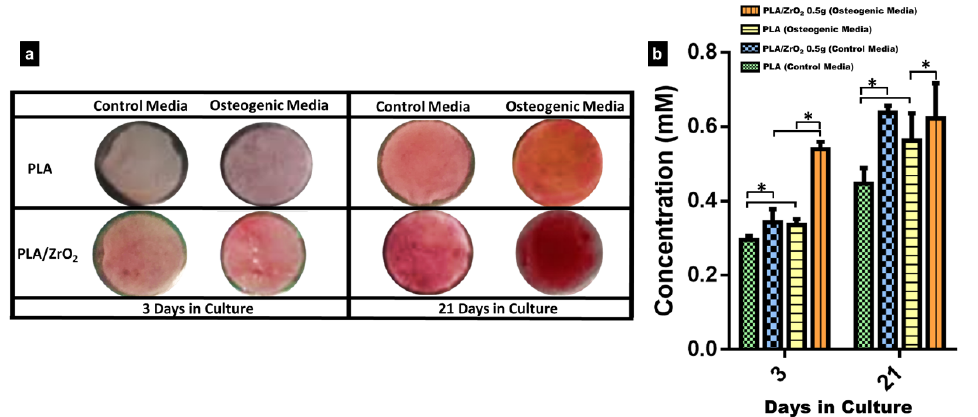
Figure 6. Alizarin red staining. The hFOB cells were cultured onto the PLA and PLA/ZrO 2 with the presence or absence of an osteogenic medium. ( a ) The calcified extracellular matrix deposits produced by hFOB cells onto the PLA/0.5 g ZrO 2 composite scaffolds are red. The area of the calcified deposits onto the scaffolds was time-dependent and increased with the culture time. However, the calcium deposit onto the PLA/0.5 g ZrO 2 scaffolds in the osteogenic medium, compared with the standard medium, was more visible, and the concentration of the alizarin was higher than in the PLA scaffolds. ( b ) The calcium (mM) concentration in PLA/0.5 g ZrO 2 scaffolds after 3 and 21 days of culture in osteogenic medium and standard medium. Asterisk (*) mean that the scaffolds showed a statistical significance ( p < 0.05). Moreover, the PLA scaffold and PLA/ZrO 2 composite fiber scaffold were analyzed by FTIR after 3 and 21 days of culture in osteoinductive culture media and compared to the control culture. From the spectra, the peaks that are characteristic of the amide I and amide II groups could be observed at 1650 cm − 1 and 1533 cm − 1, corresponding to the extra- cellular collagen matrix (Figure 7).